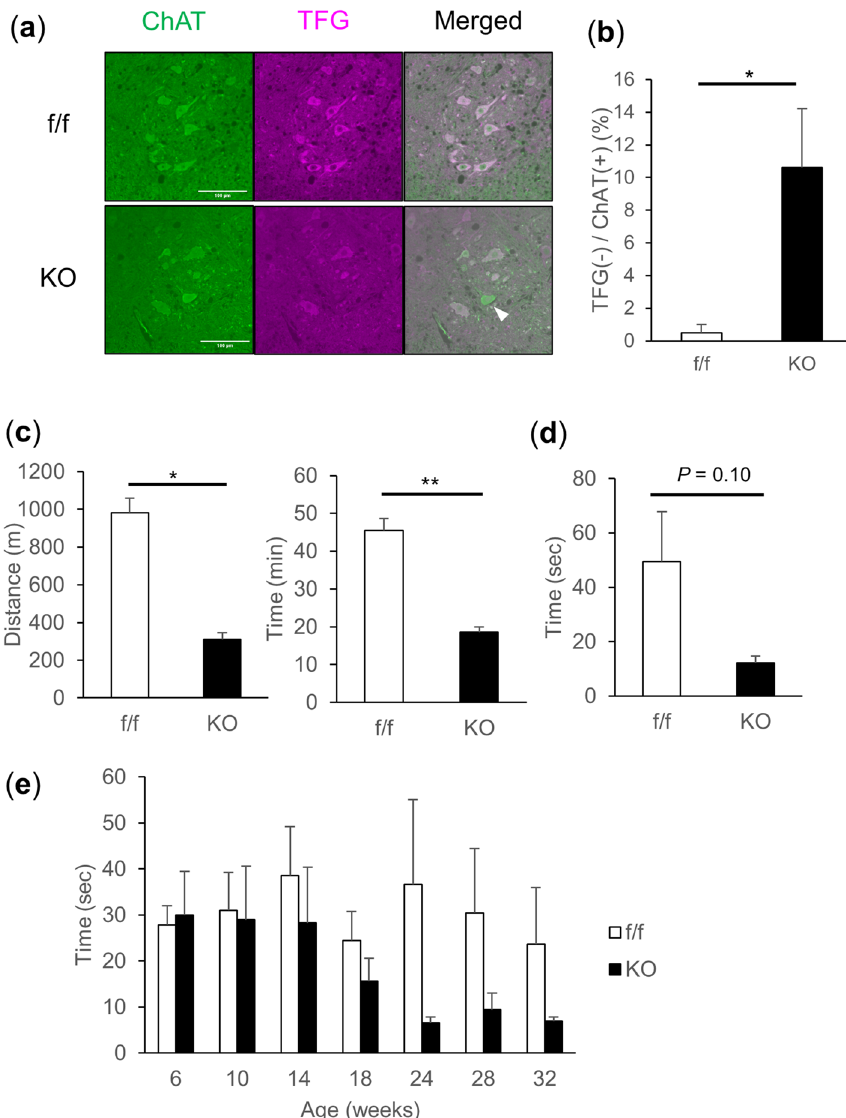
Figure 1. vMNTFG KO mice display reduced motor function (muscle weakness). ( a ) Fluorescent immunostaining against ChAT and TFG in lumbar spinal cord specimens from 6-month-old mice (scale bar: 100 µm). ChAT-positive but TFG-negative motor neuron in vMNTFG KO is indicated by arrowhead. ( b ) Percentage of TFG-negative neurons among ChAT-positive motor neurons. ChAT-positive motor neurons number 213 and 177 from f/f (n = 6) and KO (n = 5), respectively. ( c ) Treadmill test results of 4-month-old male mice (n = 4). Distance (left panel) and time (right panel) that mice ran are shown. ( d ) Latency to fall in hanging- wire test results of 4-month-old male mice (n = 4–6). ( e ) Chronological changes in performance of the hanging- wire test (n = 8–9). (* P < 0.05, ** P <